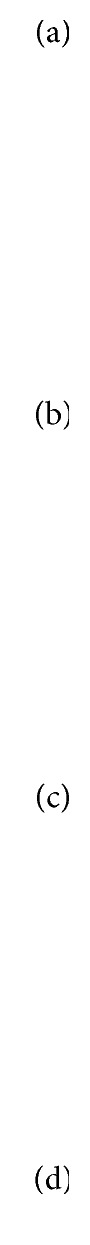
Surgical specimen of splenectomy demonstrated two lobulated yellowish lesions within the spleen (a, b). A portion of the left diaphragm was also resected due to the adhesion process (c, arrowhead).